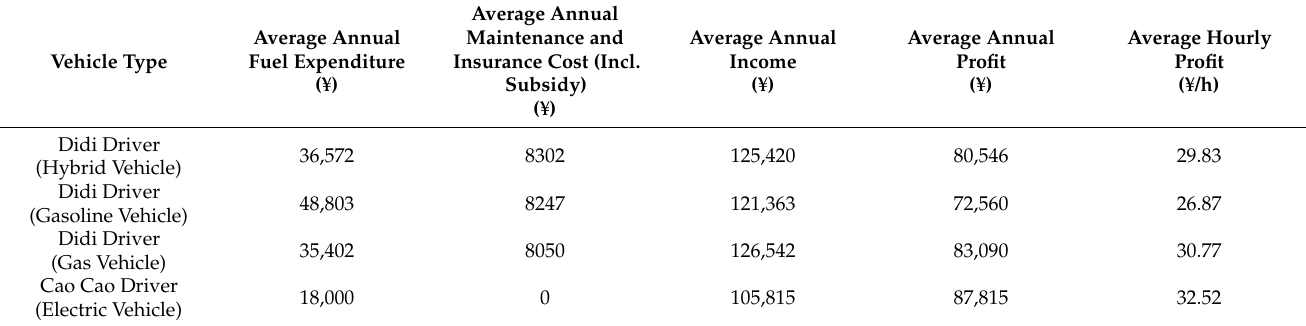
Table 9. Revenue and cost for Didi drivers and Cao Cao drivers.